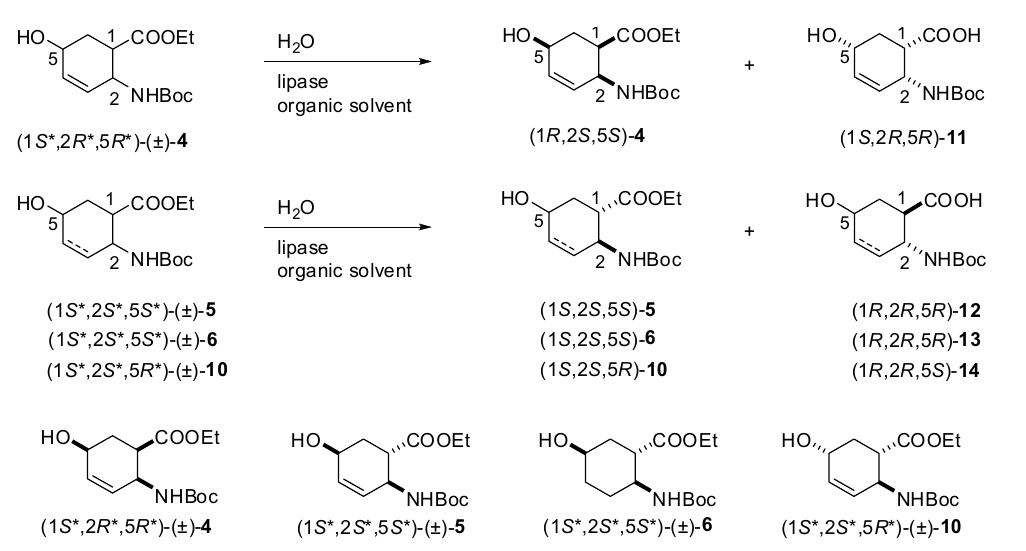
Table 1. Conversion and enantioselectivity of enzymatic hydrolysis of (1 S *,2 S *,5 R *)-( ± )- 10 a .